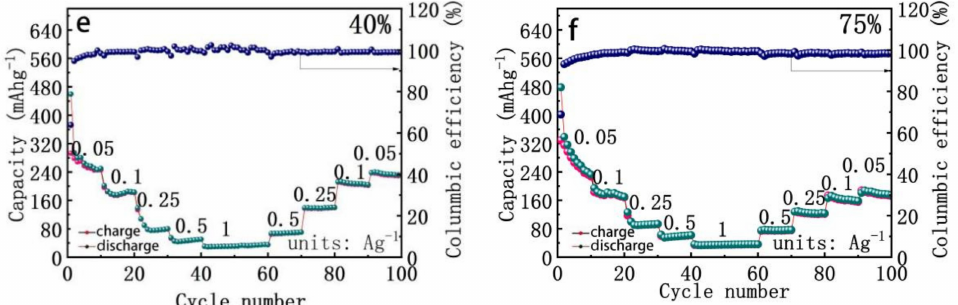
Figure 3. The electronic performance of 10%, 25%, 35%, 40%, 75% CQDs/G. Cycle of CQDs/G 1000 times ( a ), the rate of 10%, 25%, 35%, 40%, 75% CQDs/G ( b ), ( c ), ( d ), ( e ) and ( f